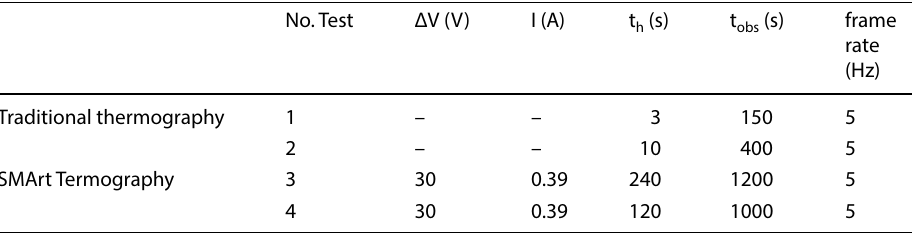
Table 3 Main parameters used for traditional and SMArt